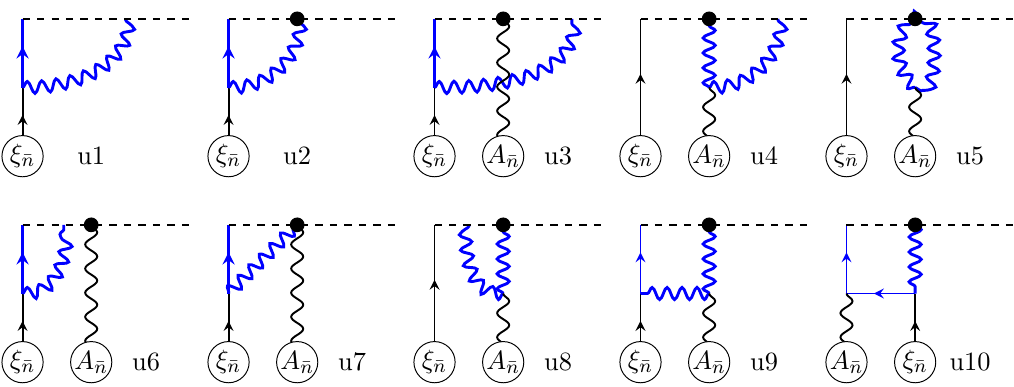
Figure 8 . The UV divergent diagrams for the operator U 1 (u1), and the operator U 2 (u2–u10). The dynamical fields are shown in blue. Wilson lines are indicated as dashed. The black dots are insertions of F . Diagrams u1, u2, and u3 also contain collinear µ +